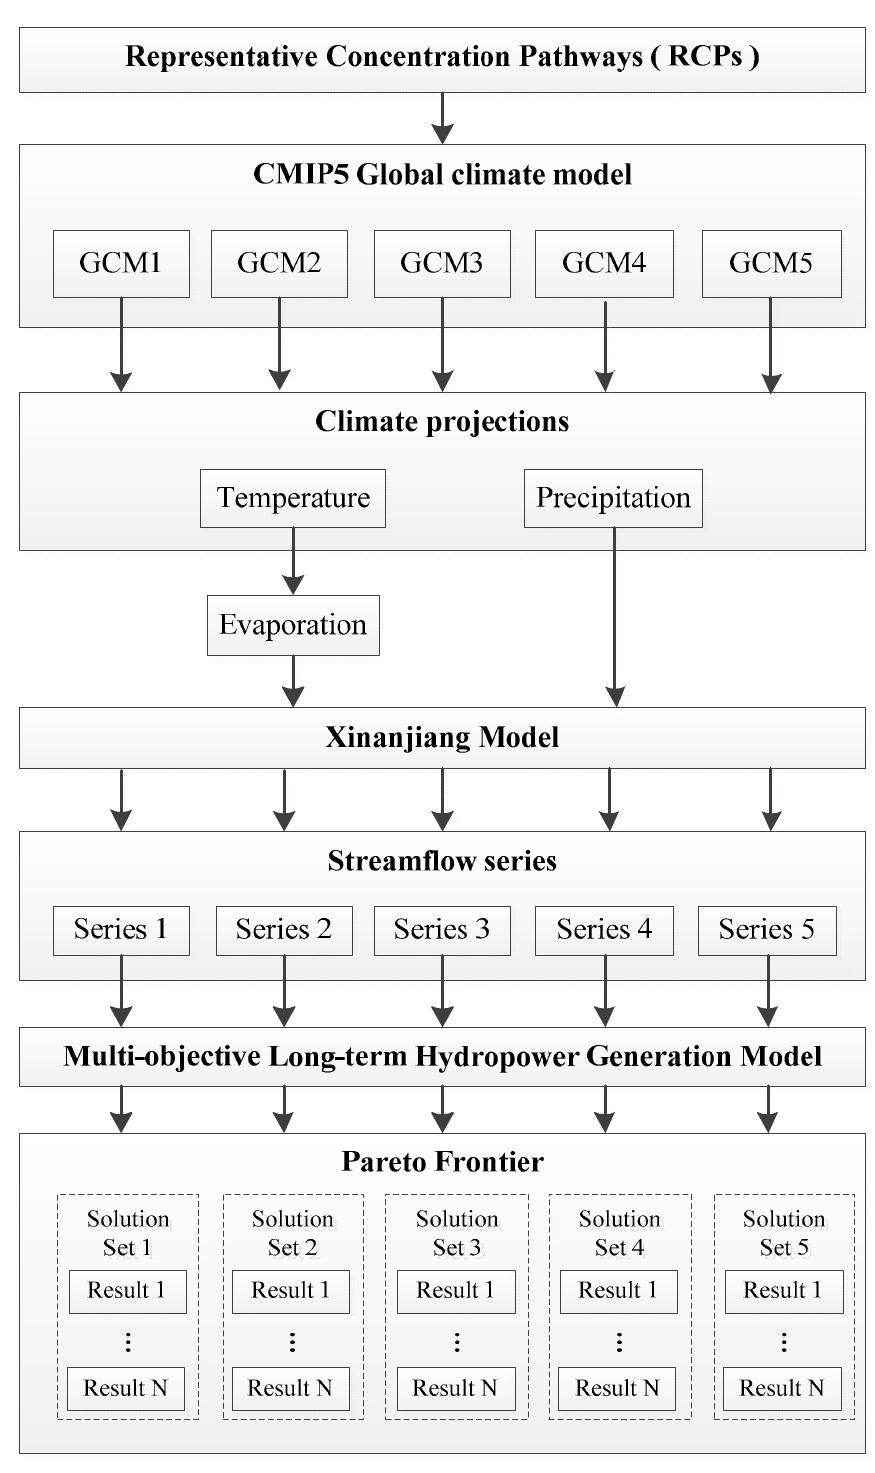
Figure 1. Flowchart for assessing the impact of climate change on hydropower generation.